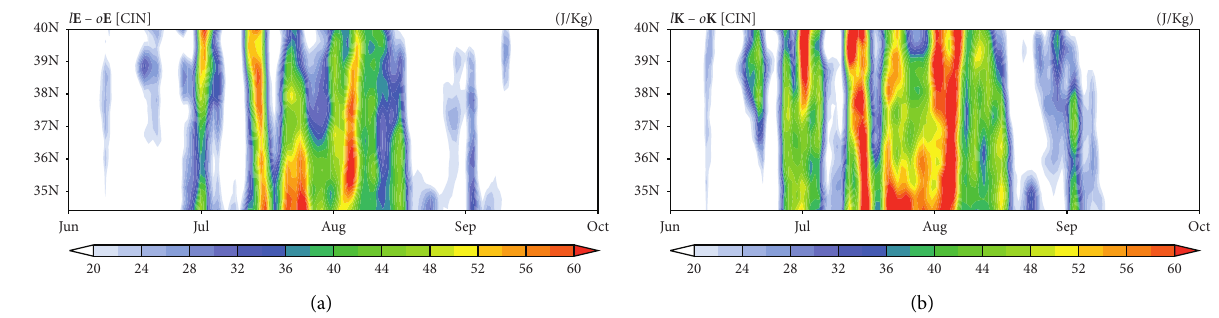
Figure 10: Time-latitude cross-sections of the 10-year JJAS period (1998–2007) daily CIN (J/kg), zonally averaged over the Korean Peninsula (126 ° E to 129.5 ° E), derived from (a) l E − o E and (b) l K − o K